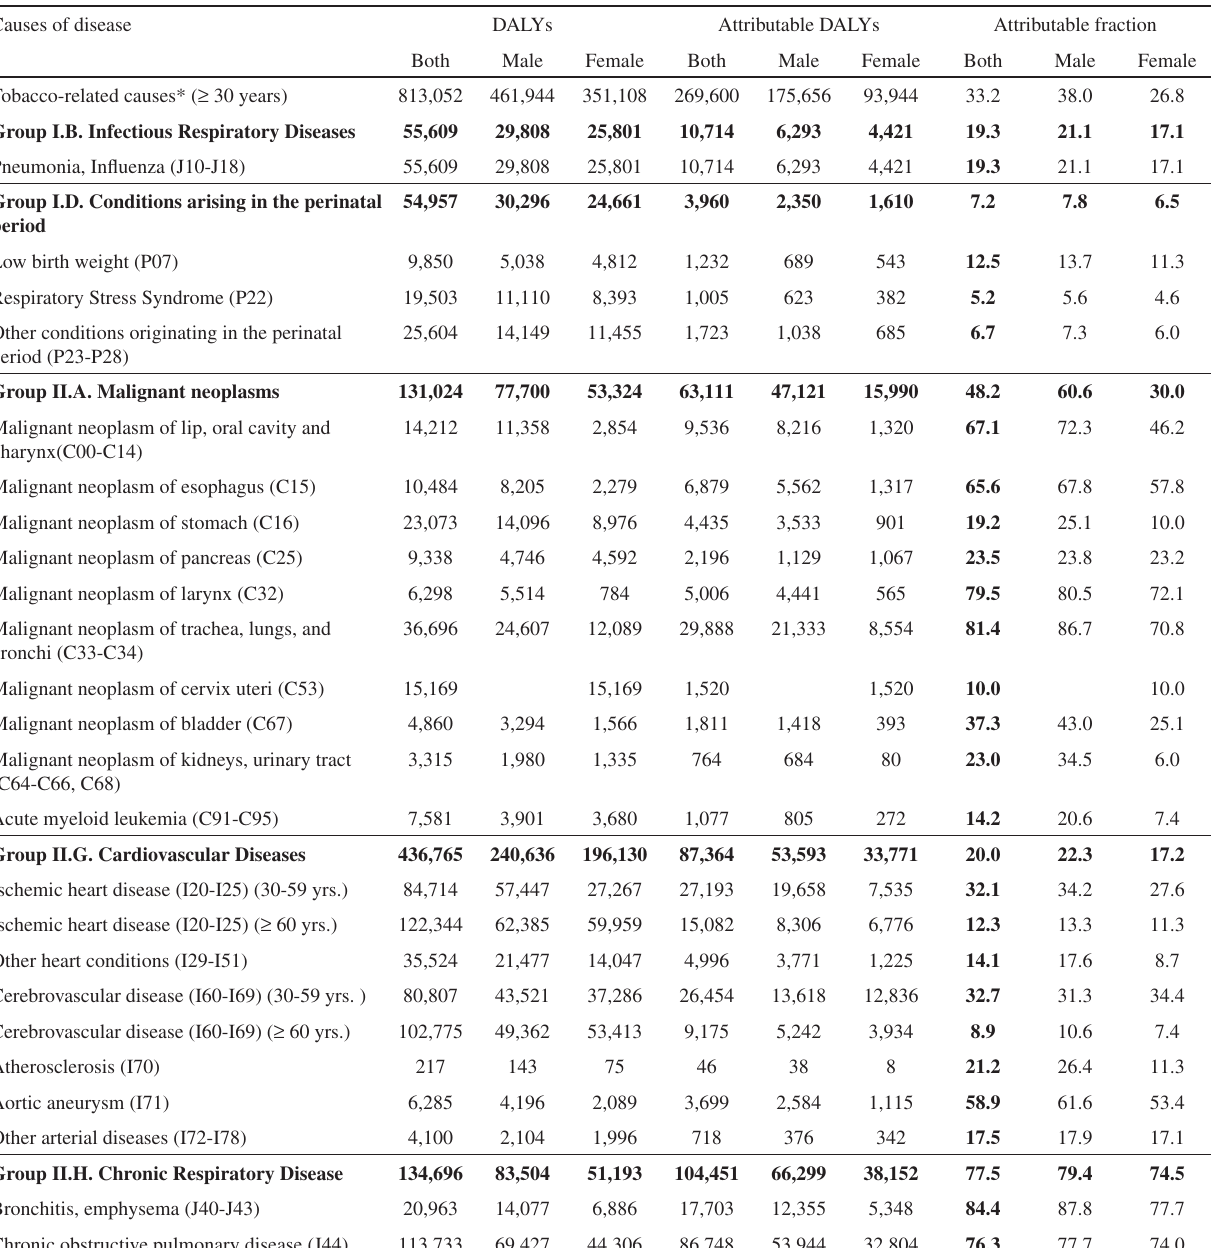
The disease burden attributable to smoking in the state of Rio de Janeiro, Brazil in 2000 Oliveira AF et al. Table 2 - DALYs, smoking-attributable DALYs, and the smoking-attributable fraction, according to gender and smoking- attributable selected diseases, (cid:113) 30 years of age . Rio de Janeiro State, Brazil.